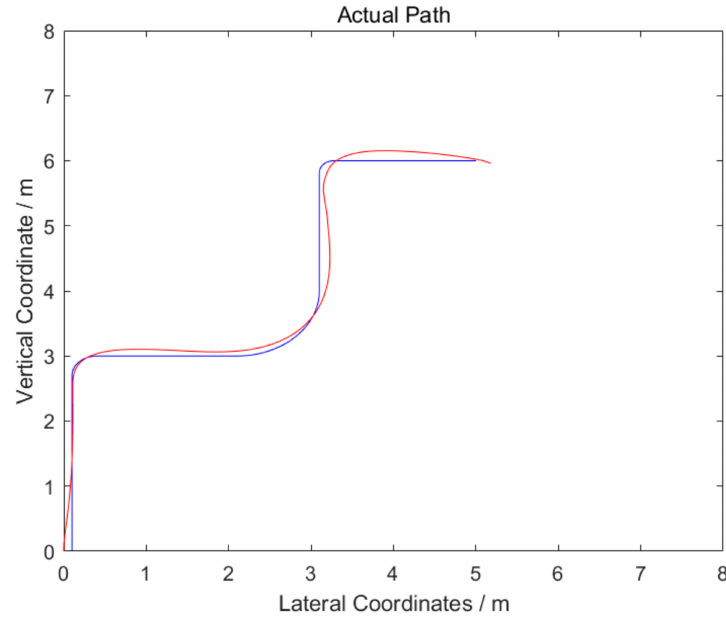
Figure 15. Actual path.